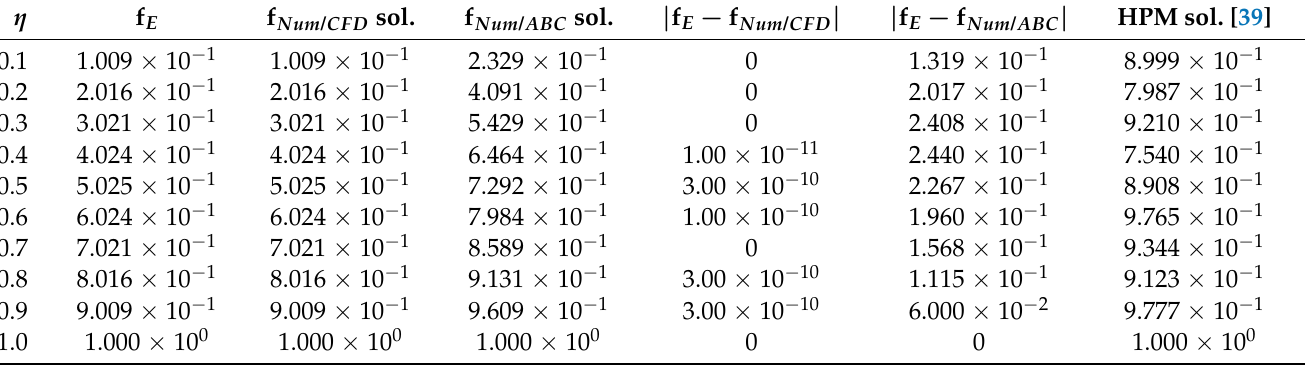
Table 1. Comparison results with exact ( f E ) IETM-numerical solutions ( f Num ) for CFD and ABC fractional derivative operator of f ( x 1 , ¯ t ) of Case 1 with absolute errors and the HPM [39] when α = 1, ¯ t = 0.01, η = 0.05, and ϕ = 0 for various values of x 1 .